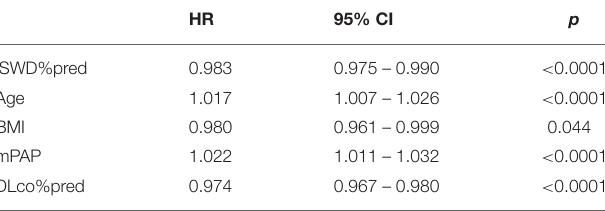
TABLE 3 | Multivariate Cox survival